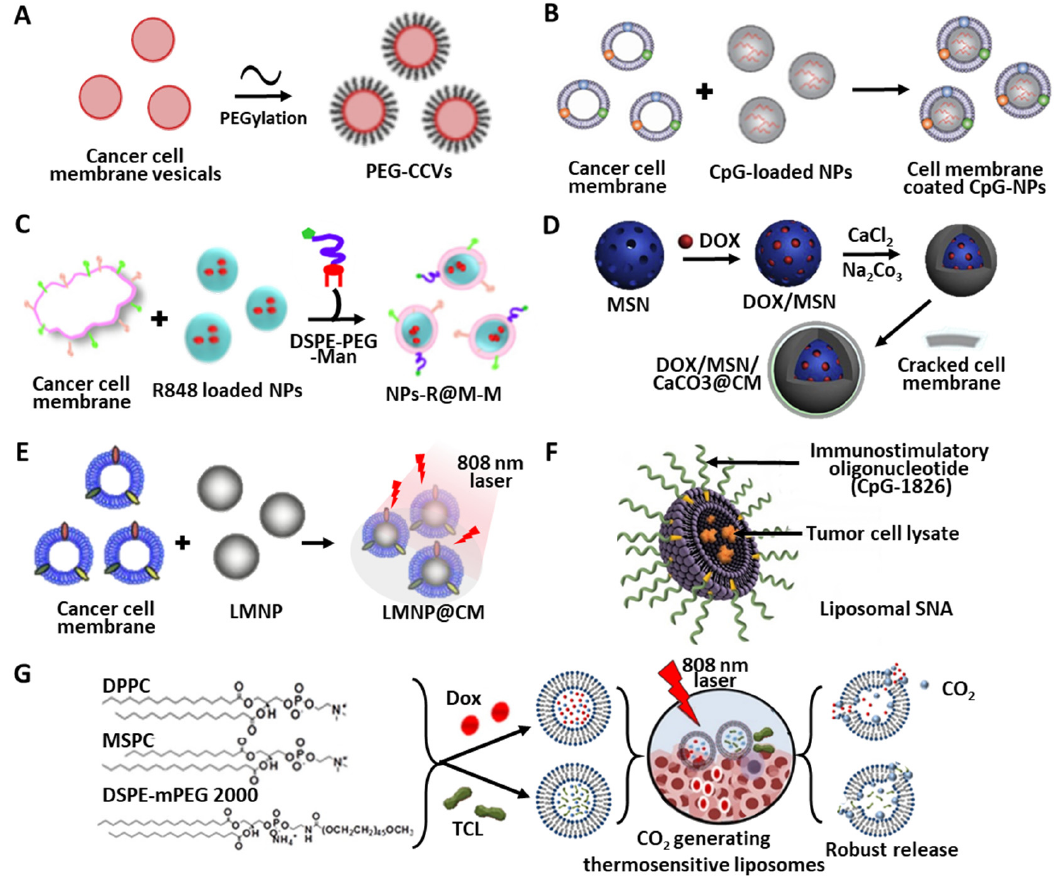
Figure 4. Schematic illustration of various biomaterial-based TCL delivery platforms. ( A ) PEGylated cancer cell membrane vesicles (CCVs) for steric stabilization, ( B , C ) PLGA nanoparticle-mediated delivery, ( D ) cancer cell membrane-coated inorganic material-based designs, ( E ) cell membrane- coated liquid metal nanoparticle with NIR irradiation, ( F , G ) cargo encapsulated within liposomal nanoparticles with lipid-mediated surface modification (All figures were reproduced with permission from Refs.